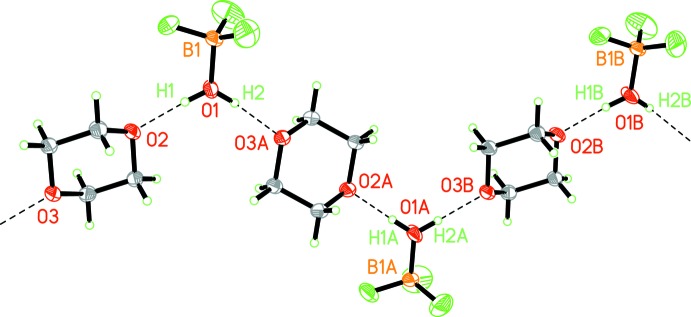
The zigzag chain of hydrogen-bonded moieties in the crystal of 1 [view direction [001]; 30% probability ellipsoids; symmetry codes: (A) −x + , y − , z; (B) x, y + 1, z]. Features indicative for the mode of concatenation of the characteristic building blocks by hydrogen bonding are: (i) double hydrogen-bond donor and double (κO,κO′) hydrogen-bond acceptor functionality of the aqua ligand and dioxane moiety, respectively; (ii) almost equal strength of both hydrogen bonds; (iii) an approximatety linear arrangement of the dioxane O atoms and the two neighbouring water O atoms (e.g. O1, O3A, O2A and O1A); (iv) an approximately planar arrangement of B1, F1, O1, O2 and O3.